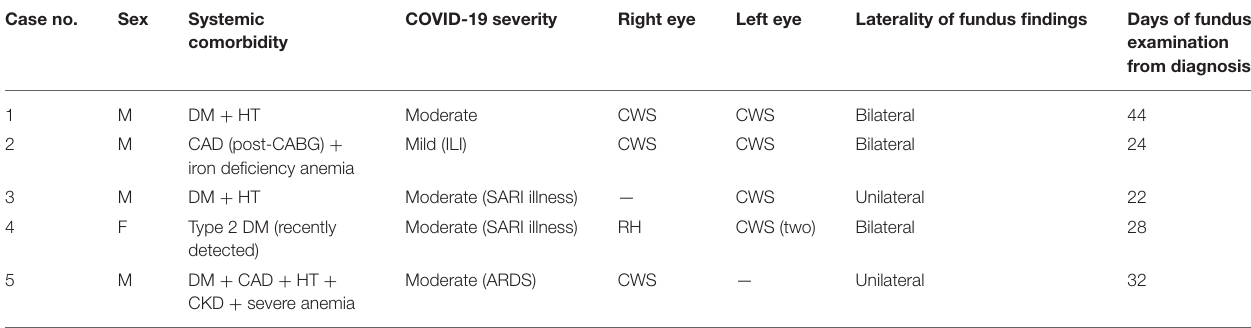
TABLE 1 | Details of COVID-19–related retinal findings. Case no.